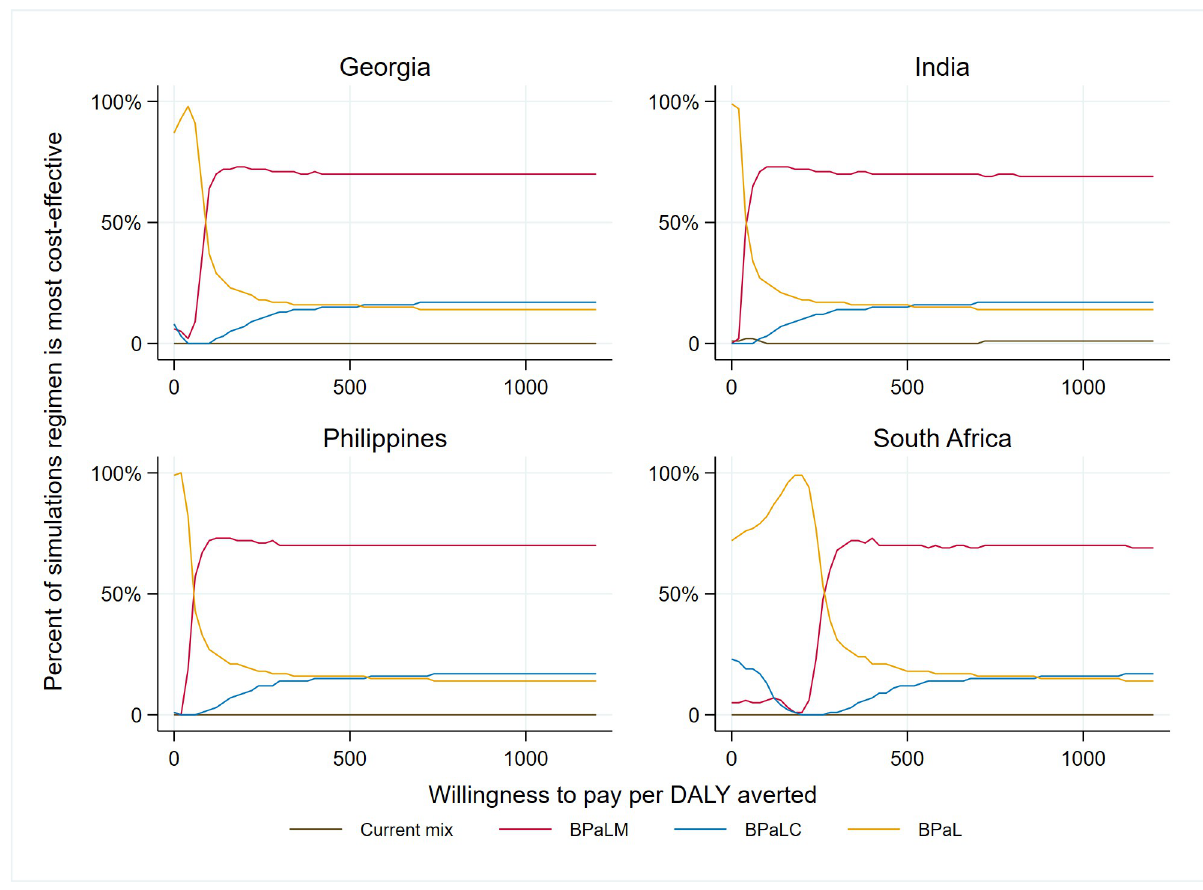
Fig 3. Cost-effectiveness acceptability